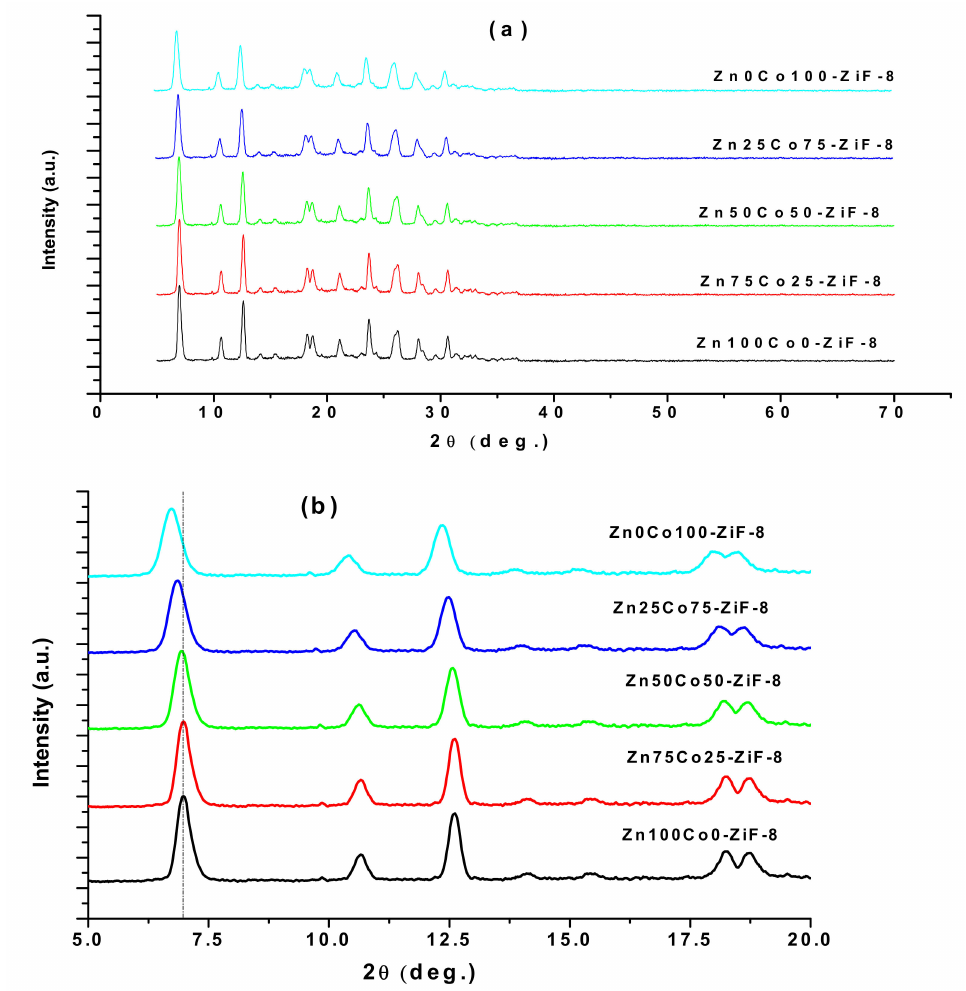
Figure 4. ( a ) The XRD patterns of different compositions of Zn x Co 1-x -ZIF-8 and ( b ) the trend of the beak in range of diffraction angle from 5 to 20 ◦